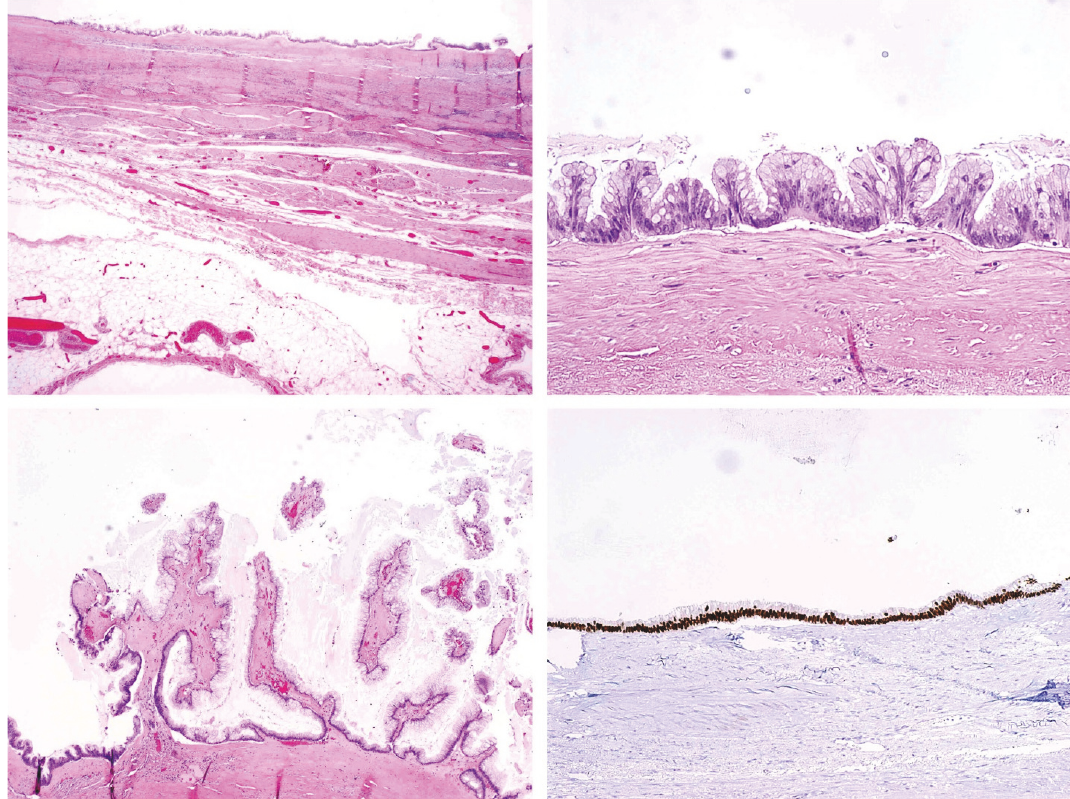
Figure 2: (a) Cyst wall showing fibromuscular wall and surface epithelial lining (20X Magnification). (b) Cyst epithelial lining with nuclear pseudostratification (H&E 200X Magnification). (c) Cyst with an area of simple papillary architecture (H&E 100X Magnification). (d) Cyst showing epithelial expression of CDX2 by immunohistochemistry (100X